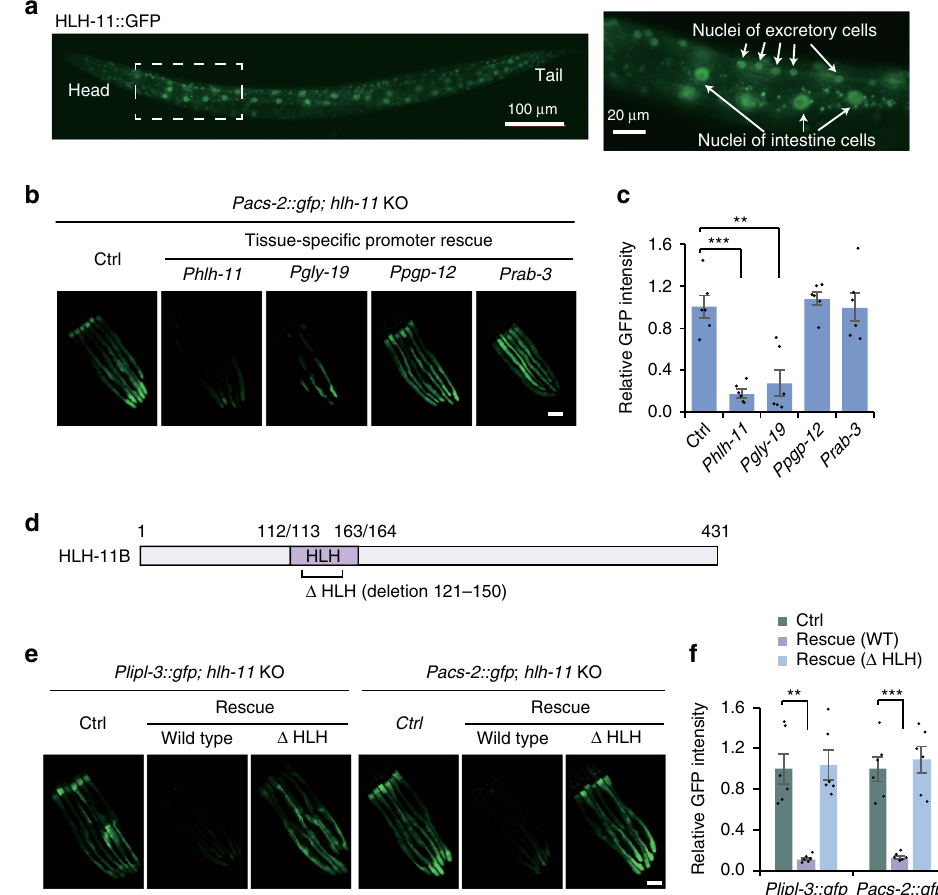
Fig. 2 HLH-11 locates in the nuclei and functions cell autonomously in the intestine to regulate lipl-3 and acs-2 expression. a Fluorescence images of Phlh-11::HLH-11::TY1::EGFP::3xFLAG worms. Eight worms were examined with similar results. b Fluorescence images of the Pacs-2::gfp reporter in hlh-11 KO worms with exogenous HLH-11 expression driven by the promoter of hlh-11 , gly-19 (intestine), pgp-12 (excretory cell), or rab-3 (pan-neuronal). Three independent experiments were performed with similar results. Scale bar, 100 μ m. c Quanti fi cation of GFP intensity in b . n = 6 worms examined per condition. *** p = 0.0003; ** p = 0.0013. d A schematic diagram depicting the HLH domain in HLH-11B. e Fluorescence images of the Plipl-3::gfp or Pacs-2:: gfp reporter in hlh-11 KO animals with expression of wild-type HLH-11 or mutant HLH-11 with the HLH domain deleted ( Δ HLH). Three independent experiments were performed with similar results. Scale bar, 100 μ m. f Quanti fi cation of GFP intensity in e . n = 6 worms examined per condition. ** p = 0.0017; *** p = 0.0007. Error bars indicate mean ± SEM. Statistical analyses were performed by Student ’ s t test (unpaired, two tailed), ** p < 0.01; *** p < 0.001. Source data are provided as a Source data fi